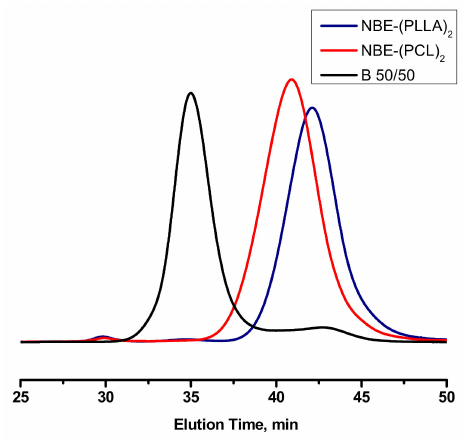
Figure 12. SEC traces monitoring the synthesis of BDBC.